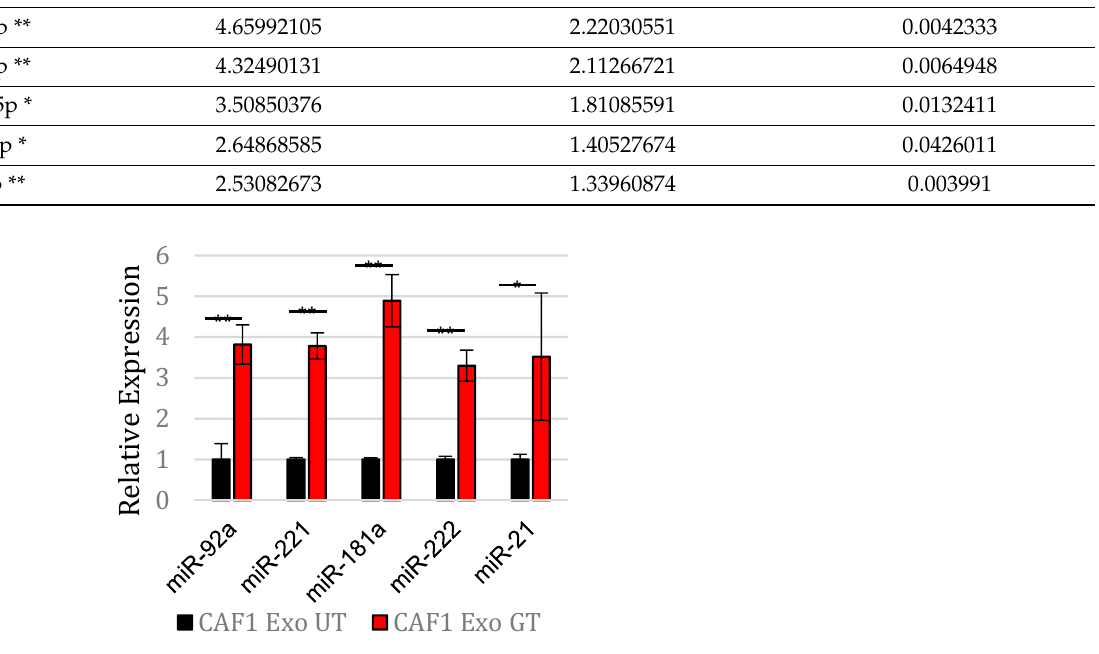
Table 1. Exosomal microRNAs significantly increased in cancer associated fibroblasts treated with gemcitabine (GEM) compared to non-treated cancer associated fibroblasts (NT). ** p < 0.01. * p < 0.05. MicroRNA Fold Change (GEM vs. NT) log2 Fold Change (GEM vs. NT) p -Value